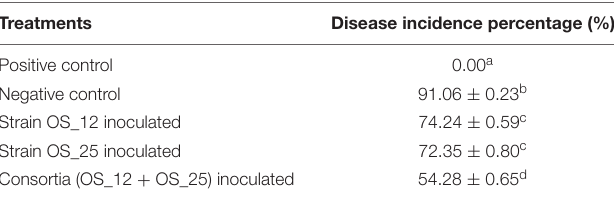
TABLE 2 | Effect of studied treatments on the incidence of root rot disease severity after 7 days of pathogen, F. oxysporum inoculation in pot experiments trials. Treatments